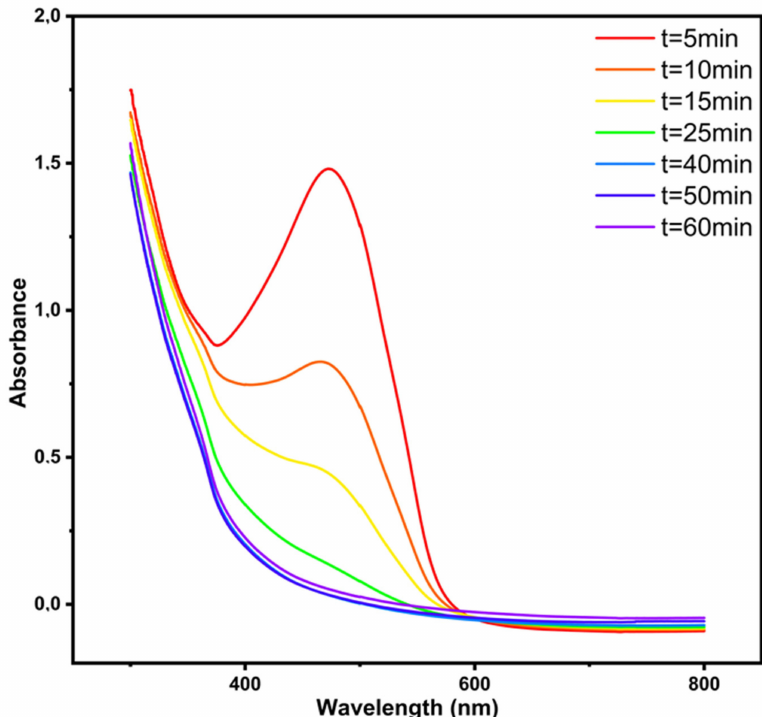
Figure 6. UV-visible absorption spectra demonstrating the progression of MO degradation over time. Reaction condition: [Fe 2+ ] = 0.2 mM, 50 mM Na 2 SO 4 , [H 2 O 2 ] = 8.8 mM, IC = 100 mA, T = 30 ± 0.1 ◦ C, and pH =